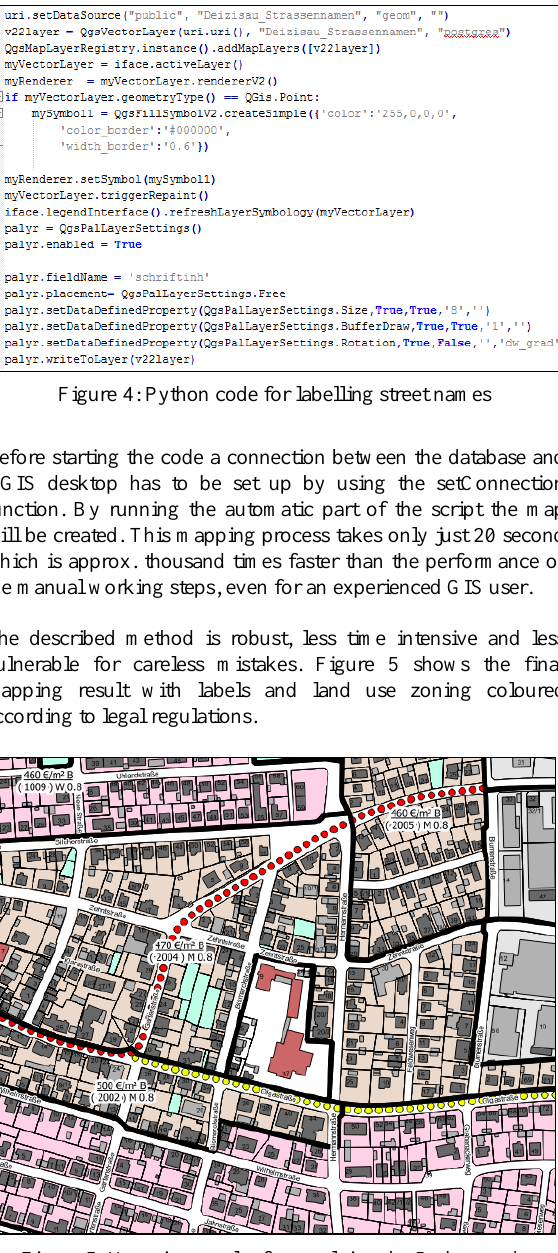
Figure 5: Mapping result after applying the Python